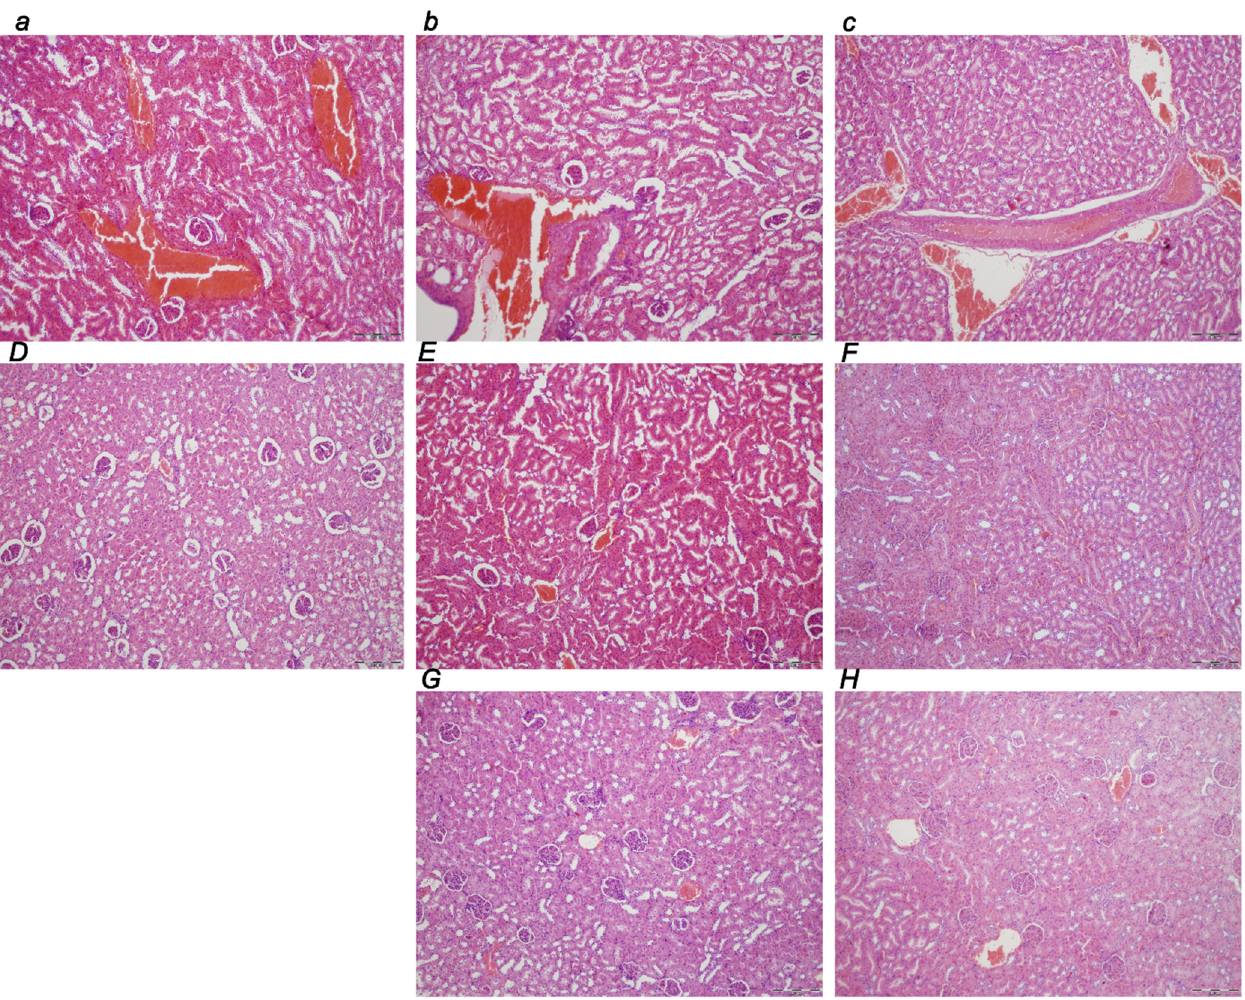
Figure 10. Kidney tissue damage illustrative microscopic presentation (HE staining; magnification 100×; scale bar 200 μ m) in rats with obstructed bile duct ( a – H ) at the end of the ligation time periods of 30 min, 5 h, and 24 h; as an early regimen at 0–30 min ( a , D ), 0–5 h ( b , E ), and 0–24 h ( c , F ) application sacrifice period; and as delayed regimen at 4.30 h–5 h ( G ) and 5 h–24 h ( H ) application sacrifice period in controls ( a – c ) and BPC 157-treated rats ( D – H ). In controls, marked dilatation and congestion of blood vessels in the kidney tissue as well as glomeruli were found at 30 min ( a ), 5 h